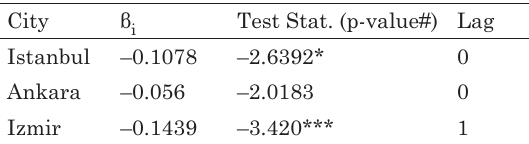
table 1. Univariate augmented dickey-fuller test